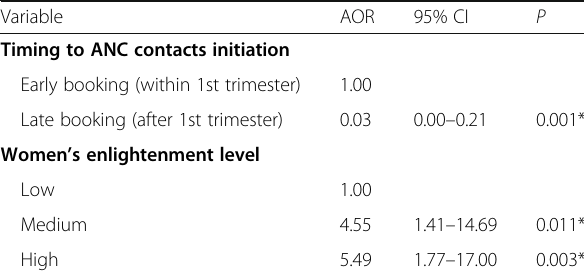
Table 2 Logistic regression of the factors associated with ≥